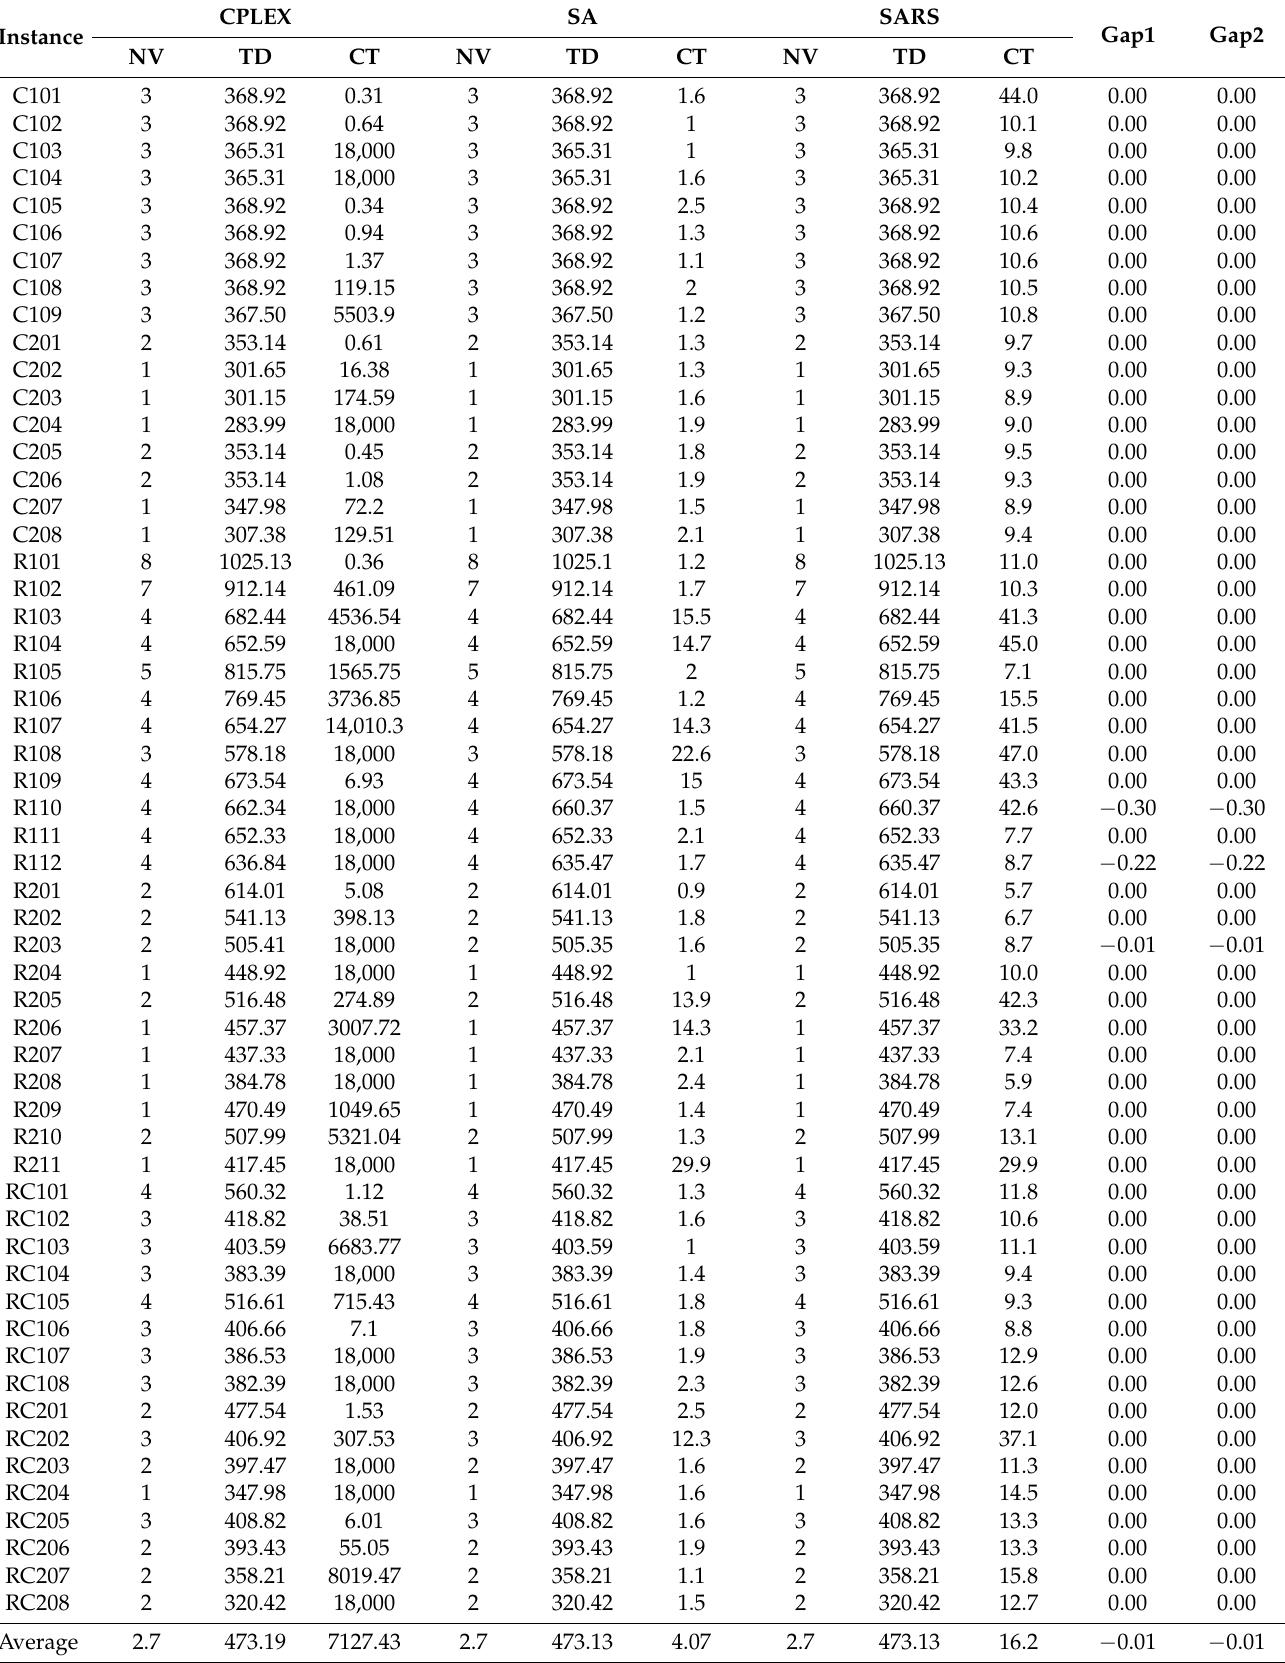
Table 8. Comparison among CPLEX, SA, and SARS on the PCPTW dataset with 25